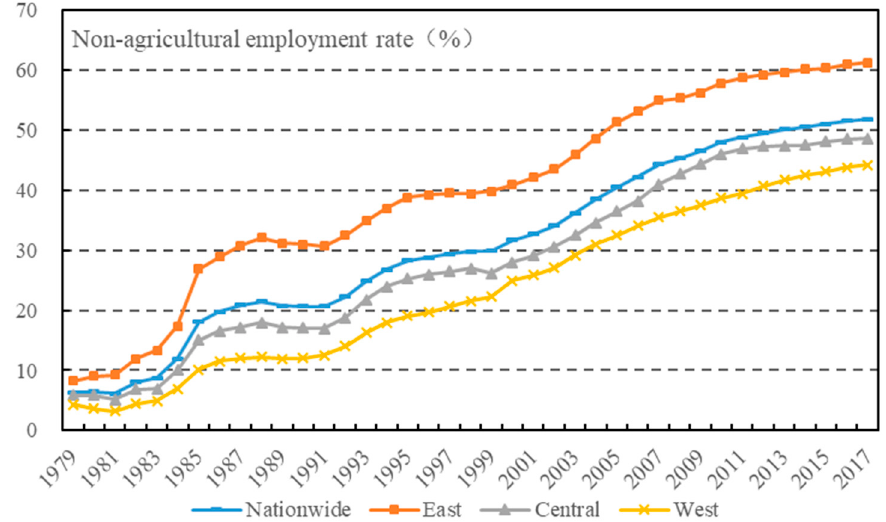
Figure 2. Non-agricultural employment change in rural labor force in China (1979–2017). Data source: Compilation of Agricultural Statistics over 30 Years after 1978, 40 Years of China’s Reform and Opening Up, China Rural Statistical Yearbook.